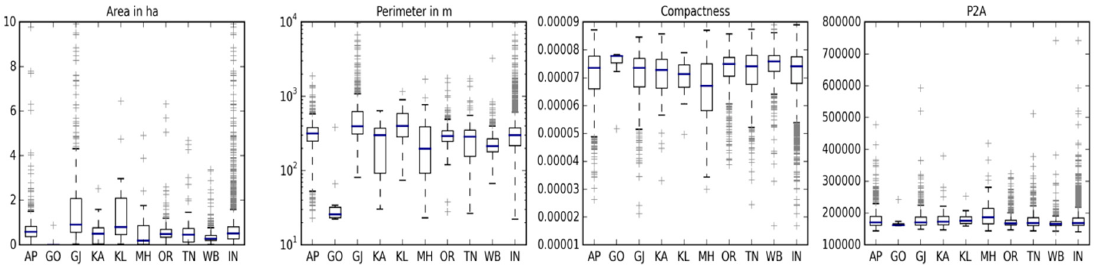
Figure 4. Box plots showing shape metrics calculated for the aquaculture pond samples from